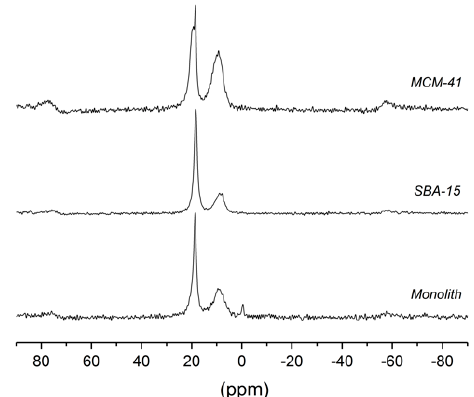
Figure 3. Possible types of attachment of a phosphonic acid to SiO 2 : ( a ) monoester; ( b ) diester; ( c ) diester with hydrogen bonding to a silanol group; ( d ) monoester with hydrogen bonding to a surface oxygen atom; ( e ) diester with Lewis acid/base interaction with a silicon atom; ( f ) pure hydrogen bond interactions.